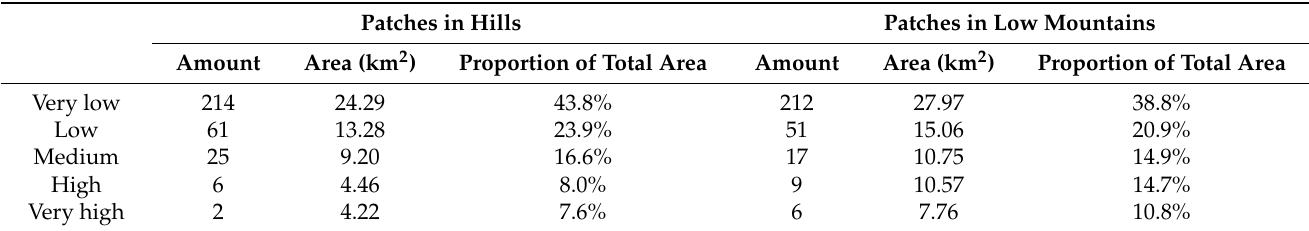
Table 5. Information of reforested patches in hills and low mountains at different